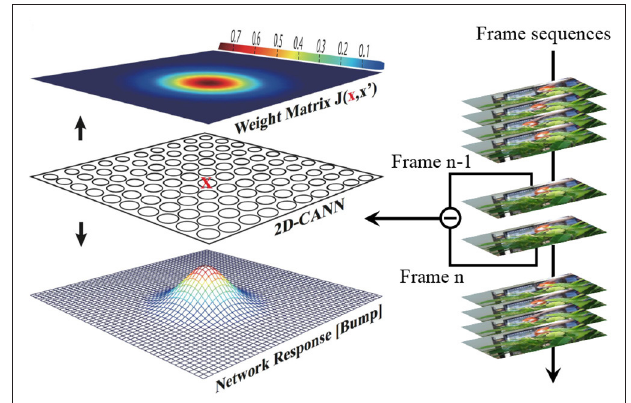
FIGURE 1 | Illustration of the CANN model.